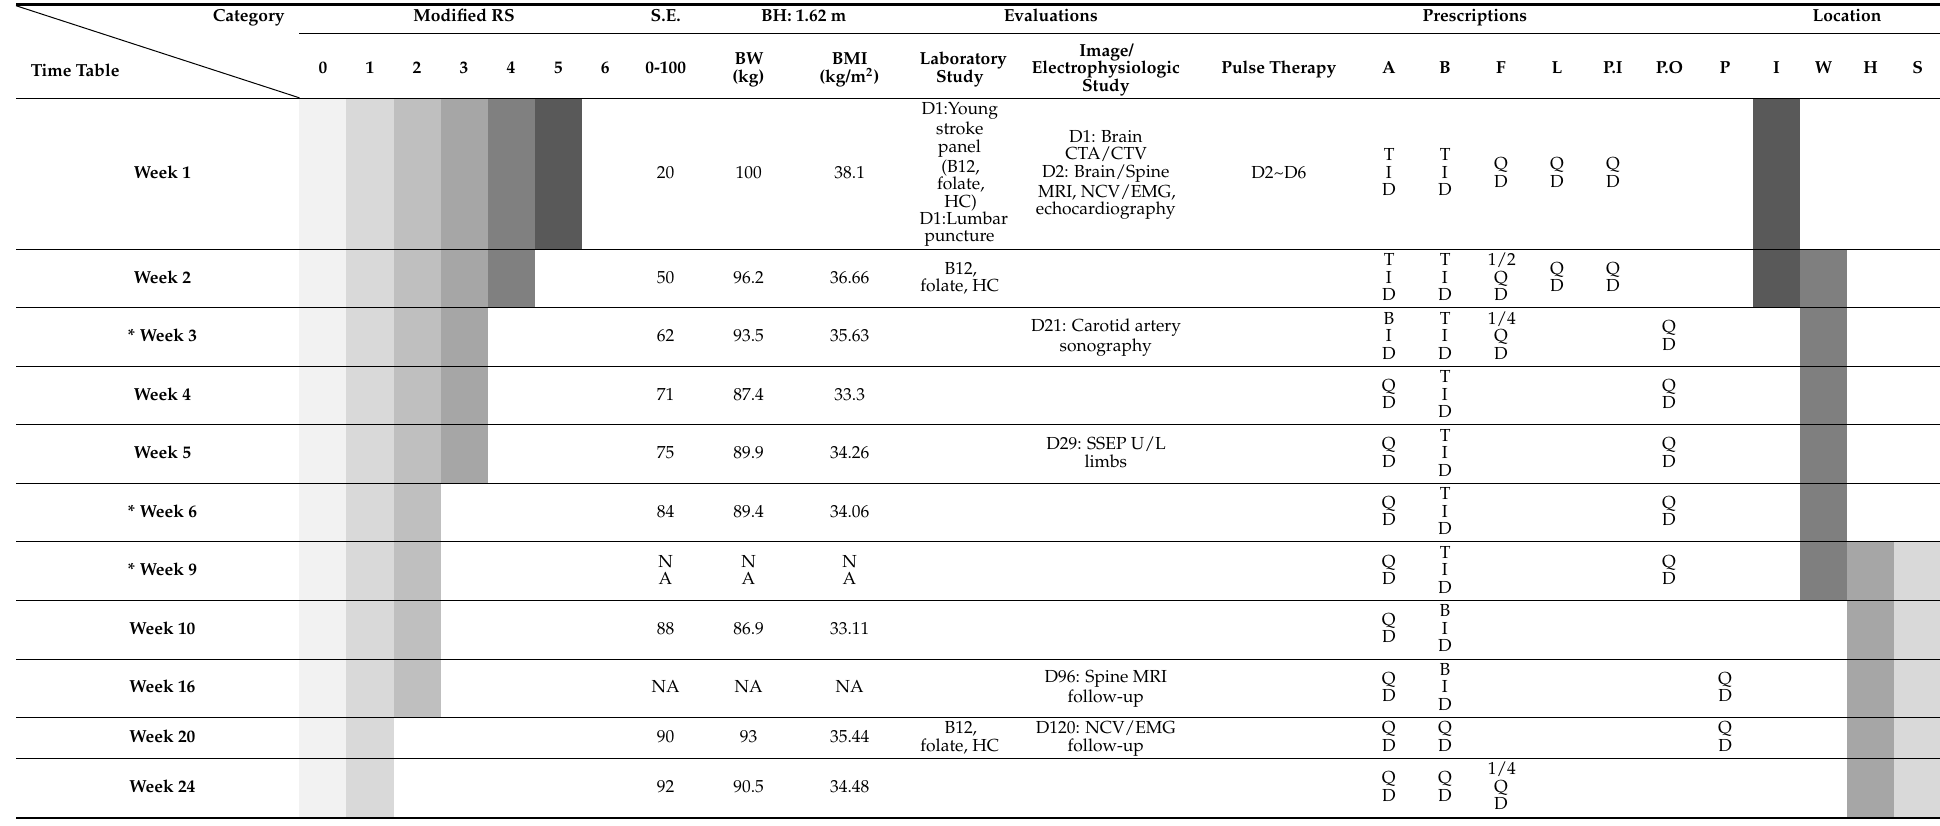
Table 1. Case presentations of disease severity/score, clinical course, evaluations, prescriptions, and locations (Gantt chart).